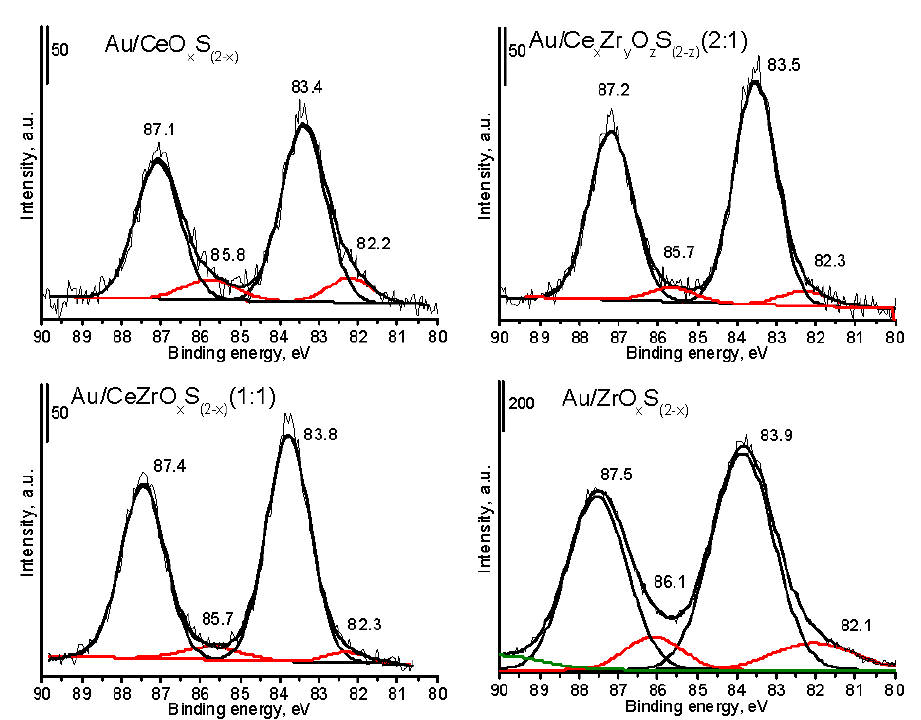
Figure 4. XP spectra recorded for Au 4f species for selected Ce-Zr oxides modified with S and Au.